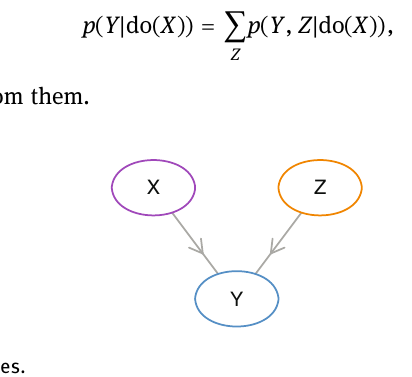
Figure 1: A v - structure on three